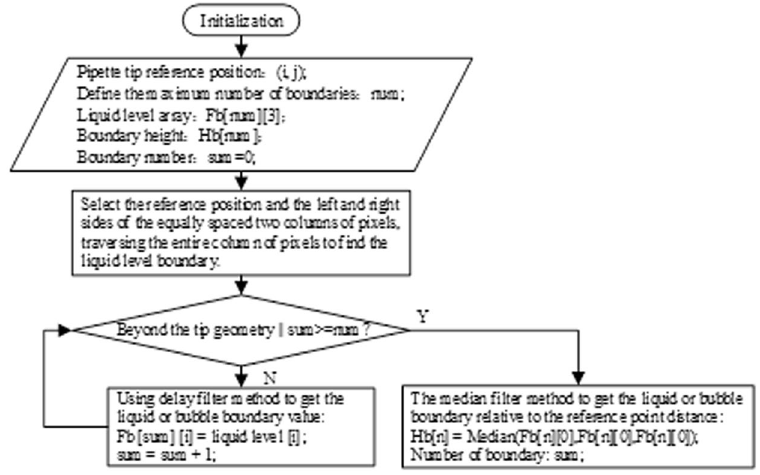
Figure 8. Algorithm of liquid surface boundary acquisition.